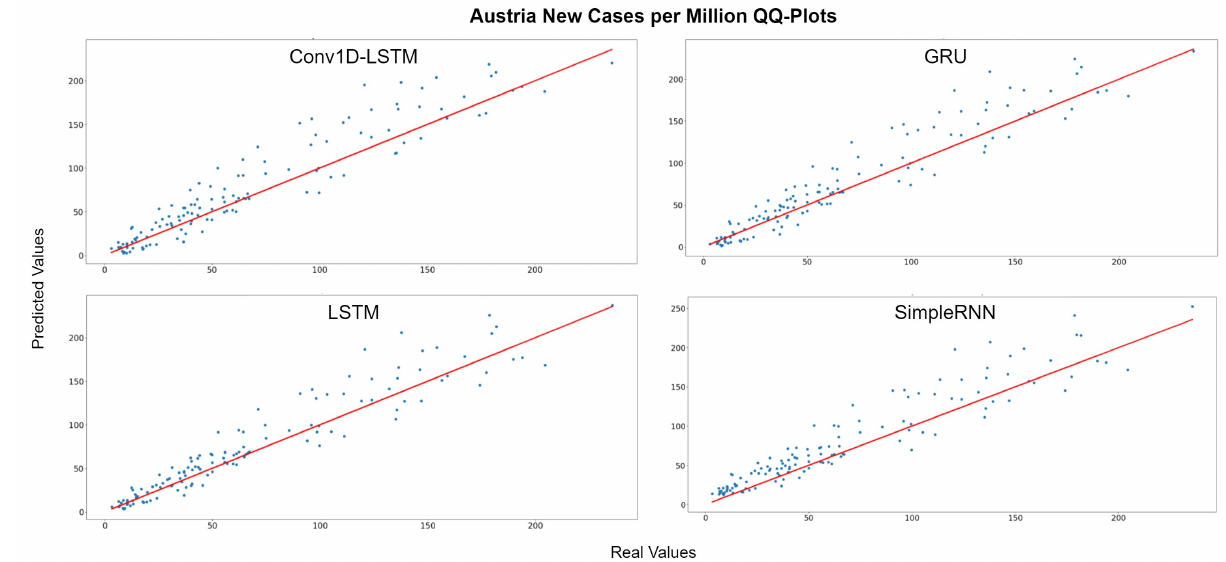
Figure 5. Austria new cases per million QQ-Plot for each